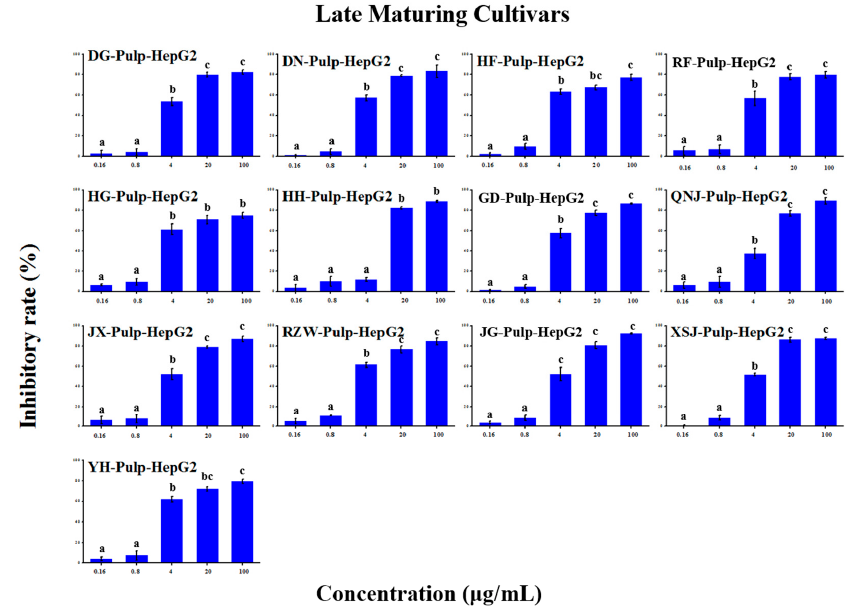
Figure 8. HepG2 growth inhibition e ff ect of pulp extracts from late maturing cultivars.The names of apple cultivars were showed as abbreviations: JX for ‘Jingxiang’, XSJ for ‘Xinshijie’, DG for ‘Danguang’, DN for ‘Dounan’, HH for ‘Huahong’, YH for ‘Yuehong’, NJ for ‘New Jonagold’, RZW for ‘Rizhiwan’, HF for ‘Hanfu’, HG for ‘Huaguan’, RF for ‘Red Fuji’, JG for ‘Jonagold’, GD for ‘Gold Delicious’. Di ff erent lowercase letters above the bars indicated significant di ff erences at the 0.05 probability level by Tukey